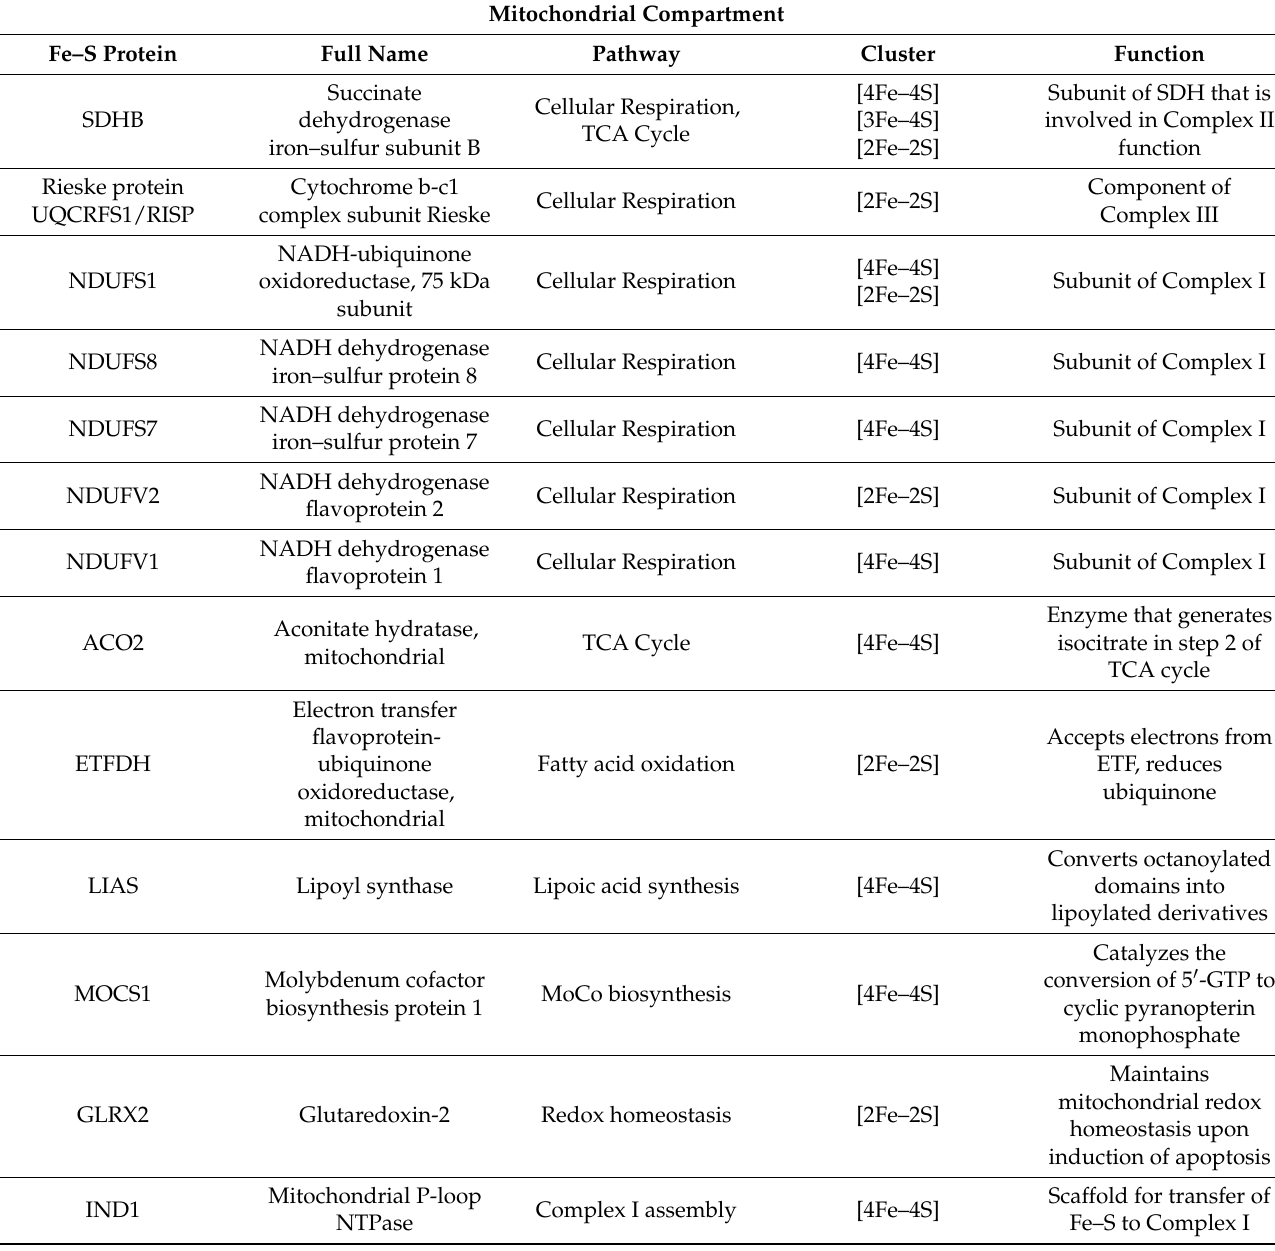
Table 1. Fe–S client proteins found in the human